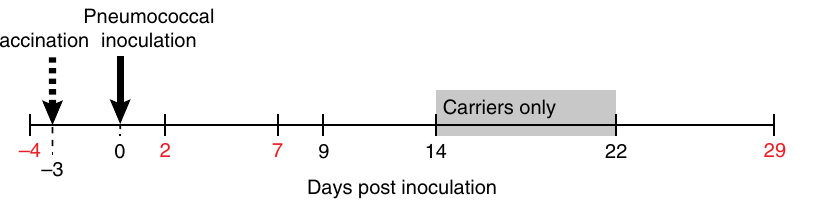
Fig. 1 Schematic overview of the study design. Volunteers were screened for pneumococcal carriage on day − 4, after which they received live-attenuated in fl uenza vaccine (LAIV) or control vaccine on day − 3 (dashed arrow), followed by pneumococcal inoculation on day 0 (solid arrow) and sampling visits on days 2, 7, 9 and 29. Only participants in whom S. pneumoniae 6B was detected by conventional culture at days 2, 7, and/or 9 were visited for sampling on days 14 and 21 (grey shaded area). Red numbers mark the time points at which microbiota data